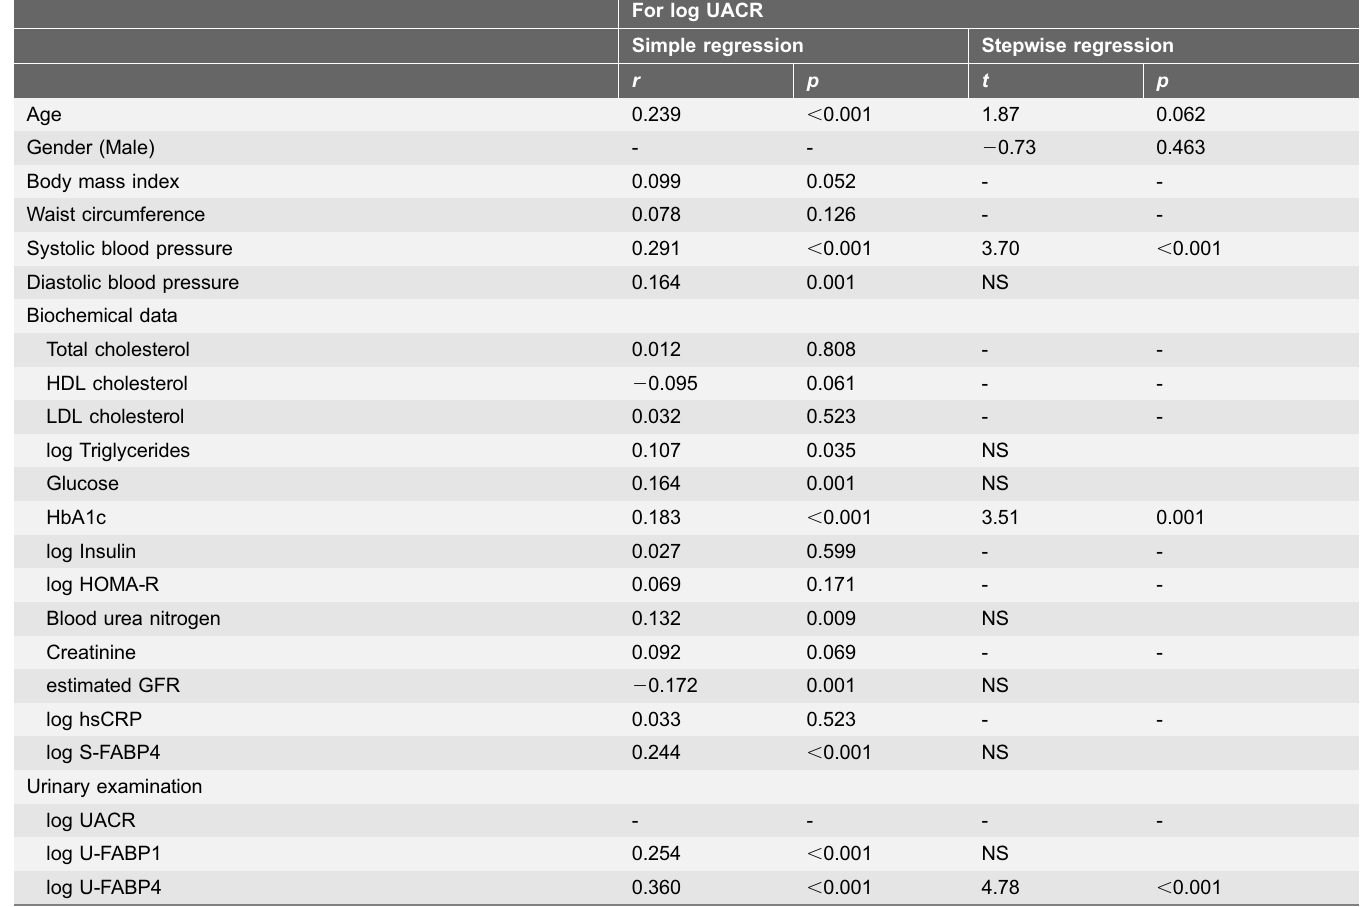
Table 4. Simple and multiple regression analyses for log UACR (n 5